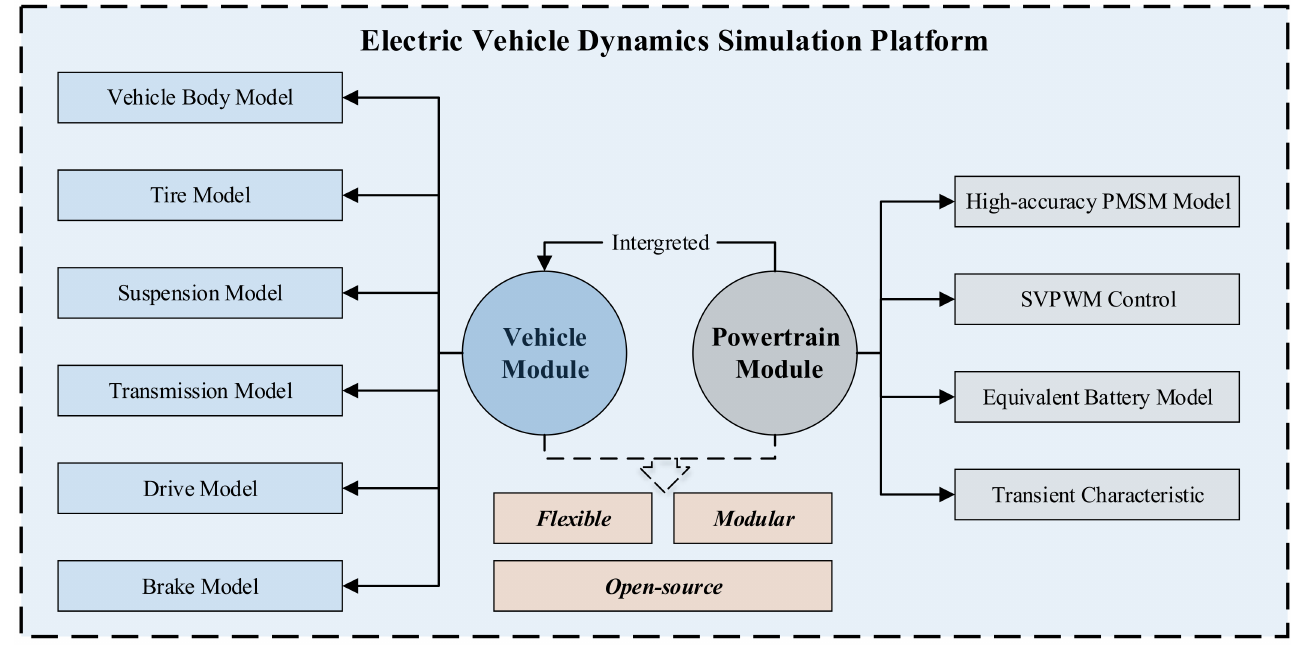
Figure 1. Graphical introduction of our simulation